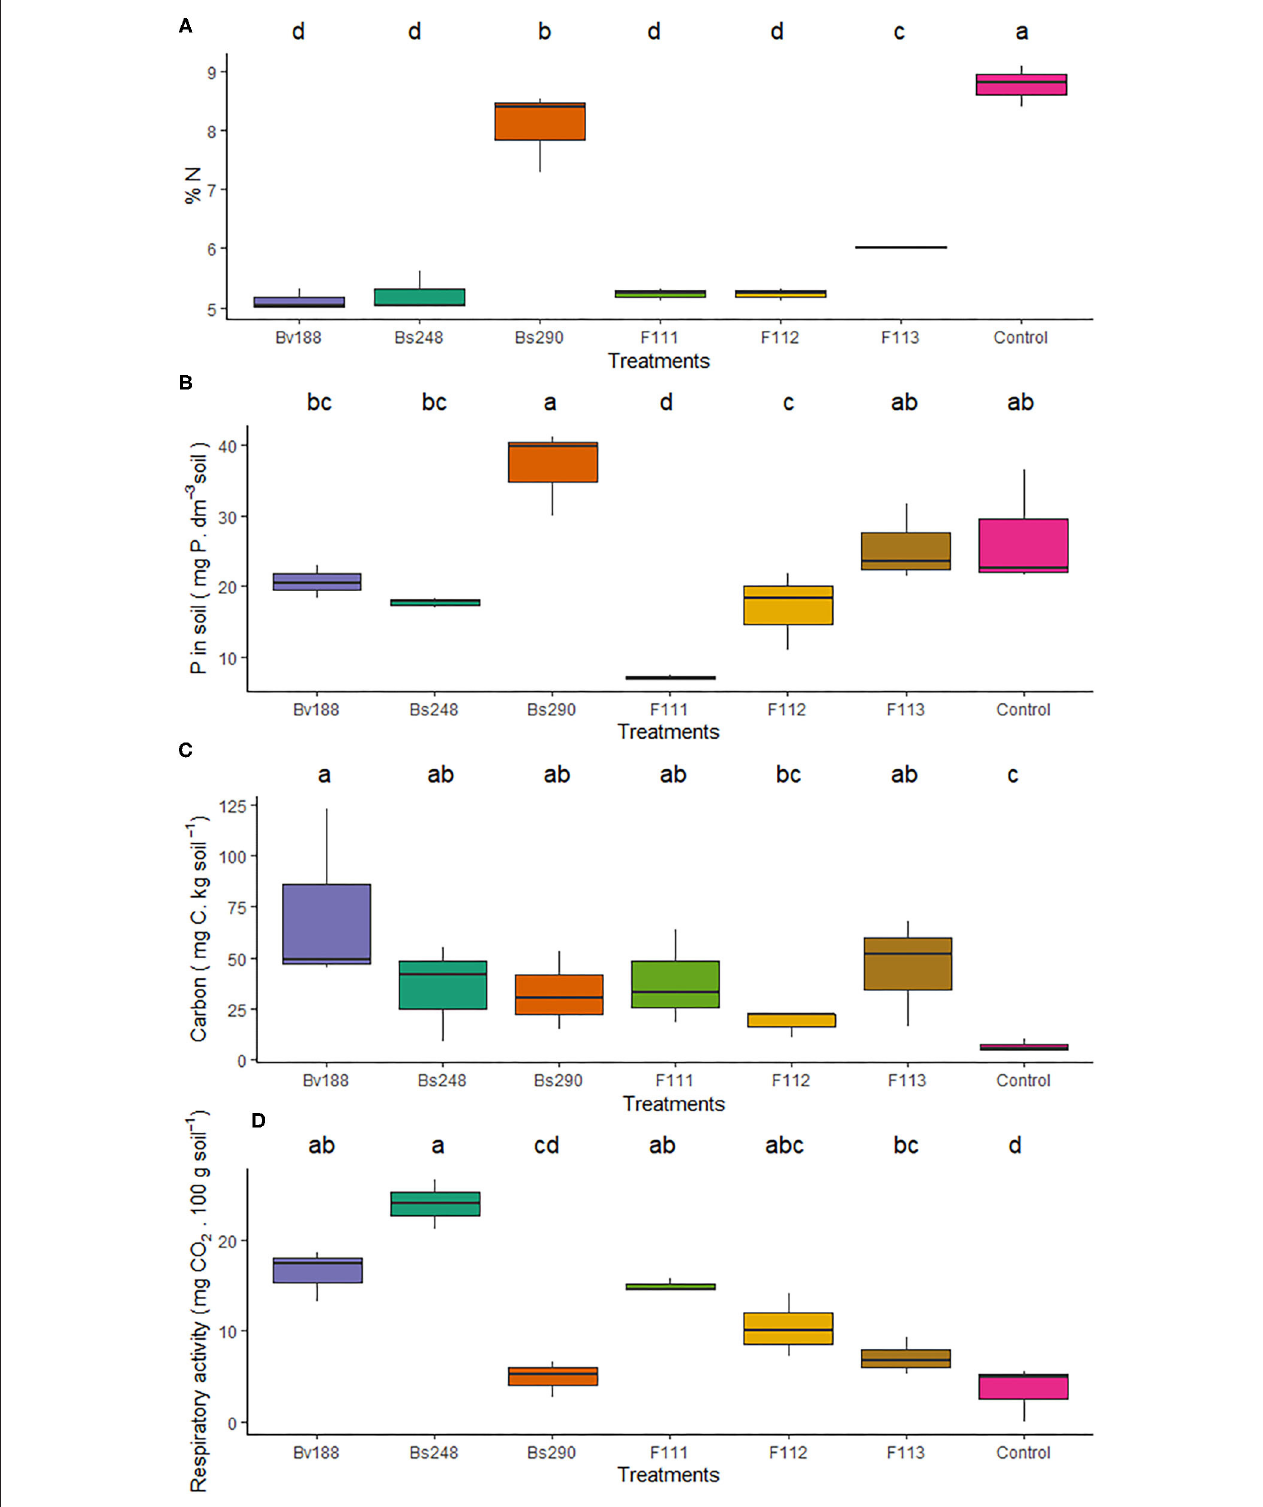
FIGURE 6 | Boxplots (median and quartiles) of the N percentage (A) , soluble phosphorus (B) , biomass carbon (C) , and respiratory activity (D) in soil inoculated with the treatments. Different letters in the rows indicate significant differences between means (Duncan’s, p < 0.05). RDM, root dry matter; SDM, shoot dry matter; TDM, total dry matter; Bv188, Bacillus velezensis strain Bv188; Bs248, Bacillus subtilis strain Bs248; Bs290, B. subtilis strain Bs290; F111, Aspergillus brasiliensis ; F112, Aspergillus sydowii ; F113, Aspergillus sp. versicolor section; Control, no inoculation.